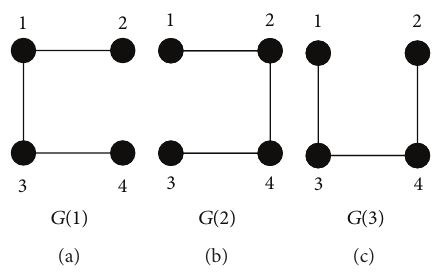
Figure 4: The topologies of the four sensors in states 1, 2, and